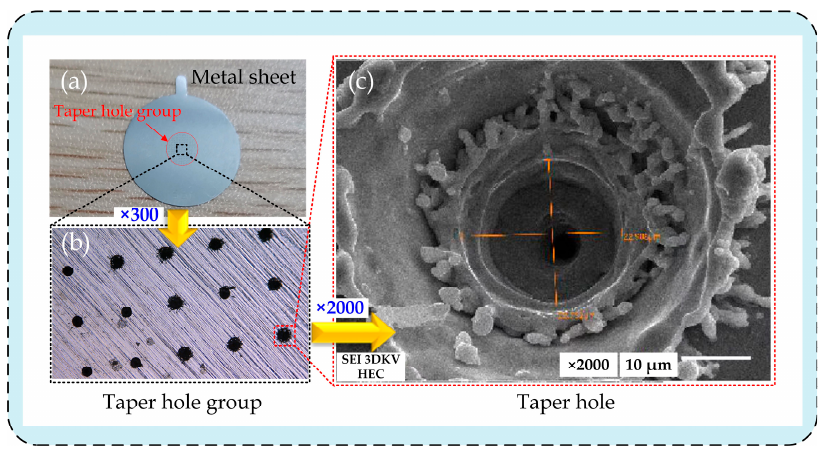
Figure 3. Tapered hole images at different magnifications: ( a ) metal sheet; ( b ) taper hole group; ( c ) taper hole.